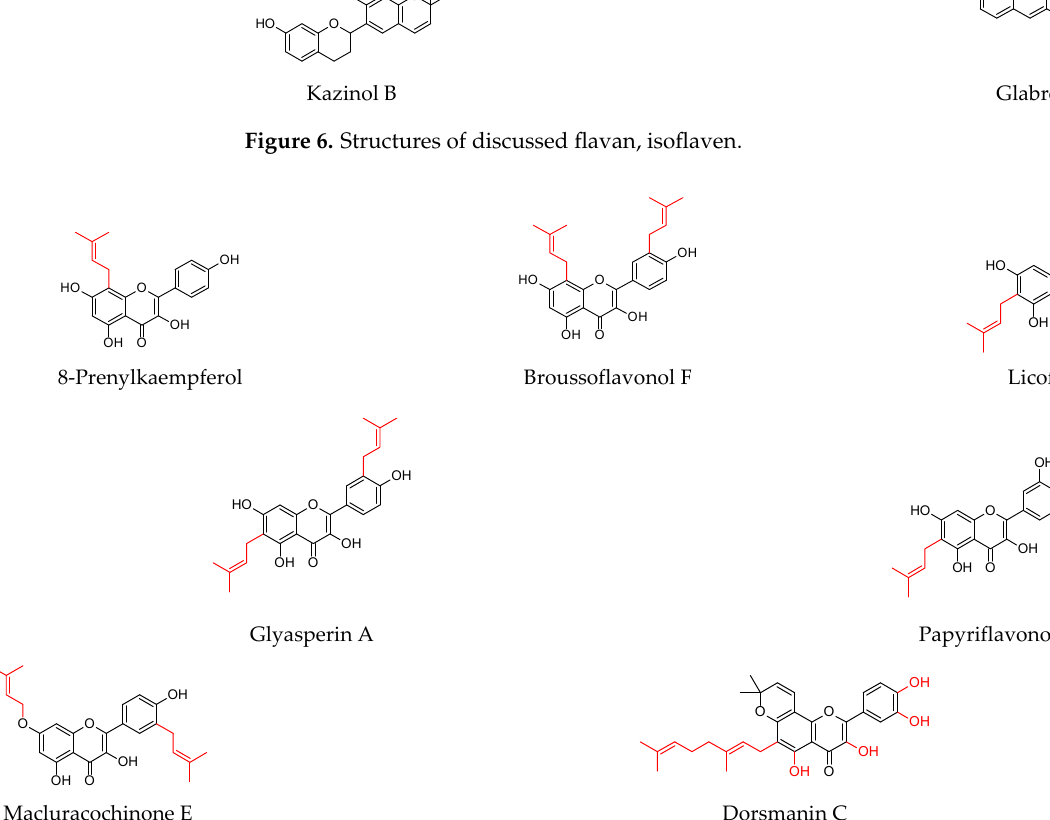
Figure 7. Structures of discussed flavonols.